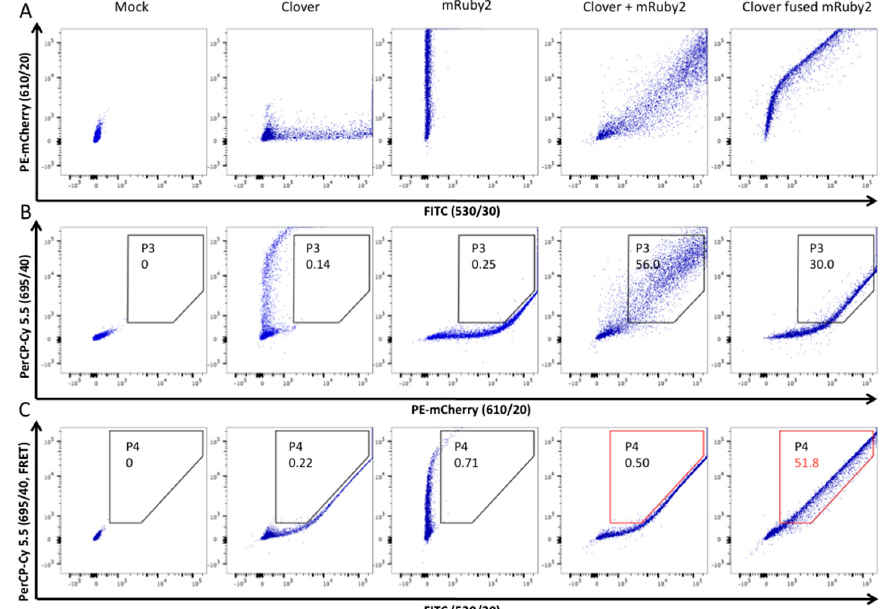
Figure 6. BD FACSAria™ III cell sorter configuration and experimental setup of Förster resonance energy transfer (FRET)-measurements. Firstly, gate P1 selecting living cells (according to forward and sideward scatter FSC-A/SSC-A) and gate P2 selecting cells in P1 (according to forward and